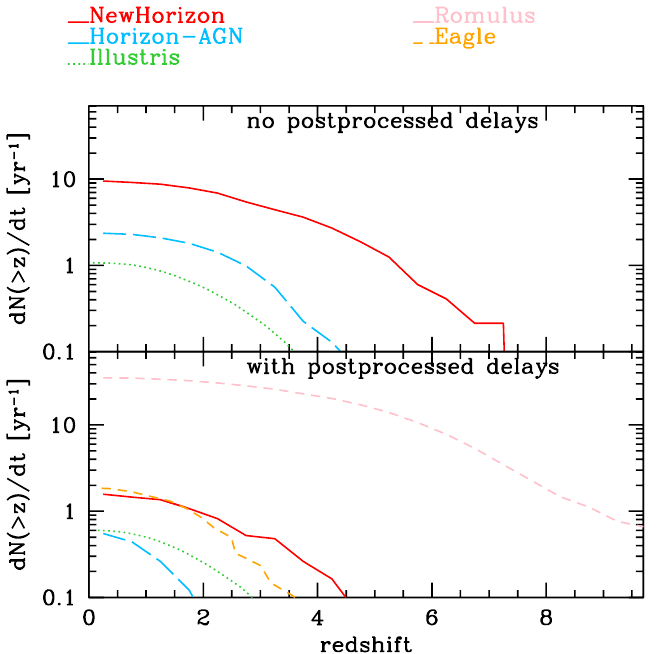
Fig. 24 Comparison of merger rates from different cosmological hydrodynamical simulations, with (bottom) and without (top) the addition of a delay in post-processing. No SNR LISA cut has been applied: this is the merger rate of all MBHs independent of whether LISA can detect them or not, e.g. most MBHs in low-resolution simulations are too massive to enter the LISA band. NewHorizon and Horizon-AGN (Volonteri et al. 2020) include intrinsic delays from dynamical friction from gas, and additional below- resolution delays (bottom panels), and model MBHs above 10 4 and 10 5 M (cid:3) , respectively. Illustris (Katz et al. 2020), with M BH (cid:1) 10 5 M (cid:3) , does not implement any intrinsic delay and adds (bottom panel) physically motivated delays in post-processing. Romulus (Tremmel et al. 2018b), where M BH [ 10 6 M (cid:3) , includes intrinsic delays from dynamical friction from particles, and a fi xed 0.1 Gyr below-resolution delay. Eagle (Salcido et al. 2016) seeds MBHs with M BH (cid:1) 10 5 M (cid:3) and does not include any intrinsic delay, adding in post-processing fi xed delays of 0.1 Gyr for gas-rich galaxies and 5 Gyr for